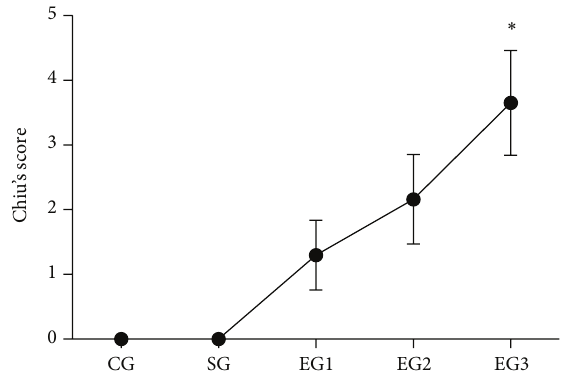
Figure 4: Chiu’s score in each group. CG = control group; SG = sham group; EG1 = exposure group with peritoneal air exposure for 1h; EG2 = exposure group with peritoneal air exposure for 2 h; EG3 = exposure group with peritoneal air exposure for 3 h. Values are expressed as mean ± SD. ∗ 𝑃 = 0.000 , compared with